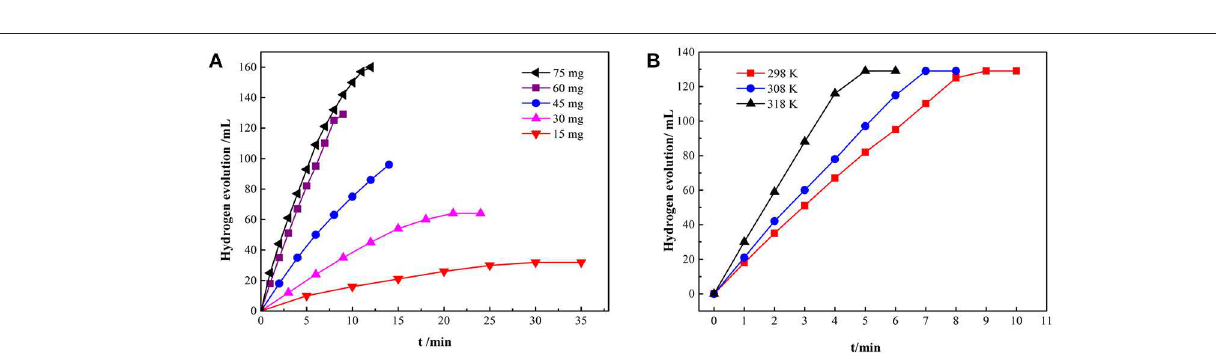
of PAF-72 is 582 m 2 g − 1 . The pore size distribution is